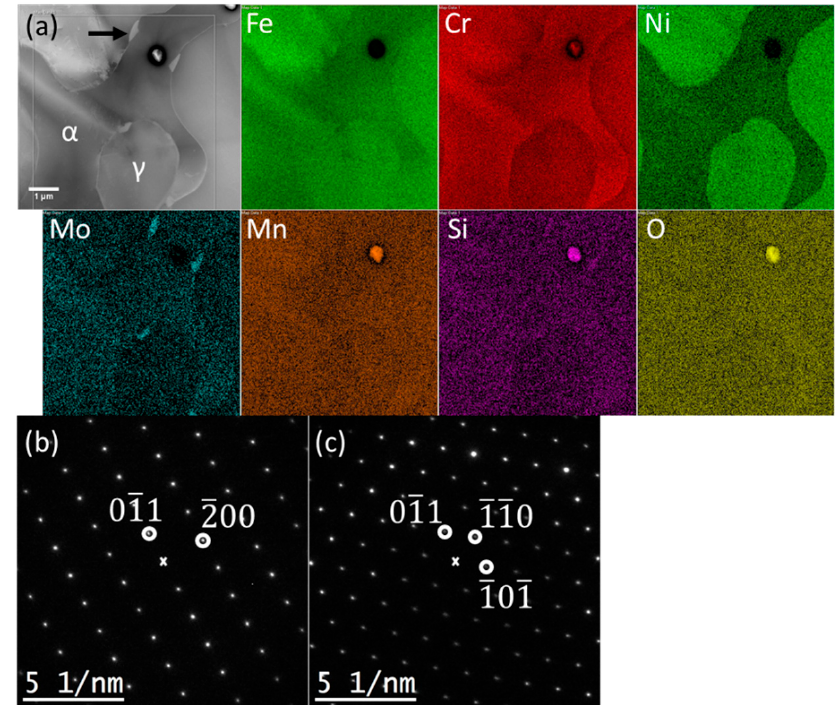
Figure 16. ( a ) HAADF STEM image and corresponding EDX maps from an area of Wall 3 with several particles. The Mo-rich particles were identified as the bcc chi phase. The oxide particle might be of the bcc Mn 3 Cr 2 (SiO 4 ) 3 phase (Ottonello, 1996 [25]). ( b ) Diffraction pattern from the [011] zone axis of the chi particle pointed to by a black arrow in ( a ). The Miller indices of the circled reflections are indicated. ( c ) Diffraction pattern from the same chi particle near the [-111] zone axis, tilted 35° from ( b ).